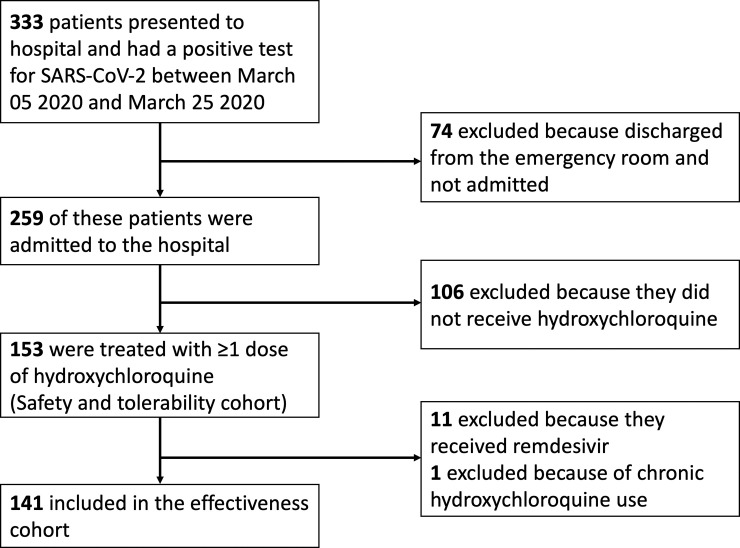
Study flow diagram.